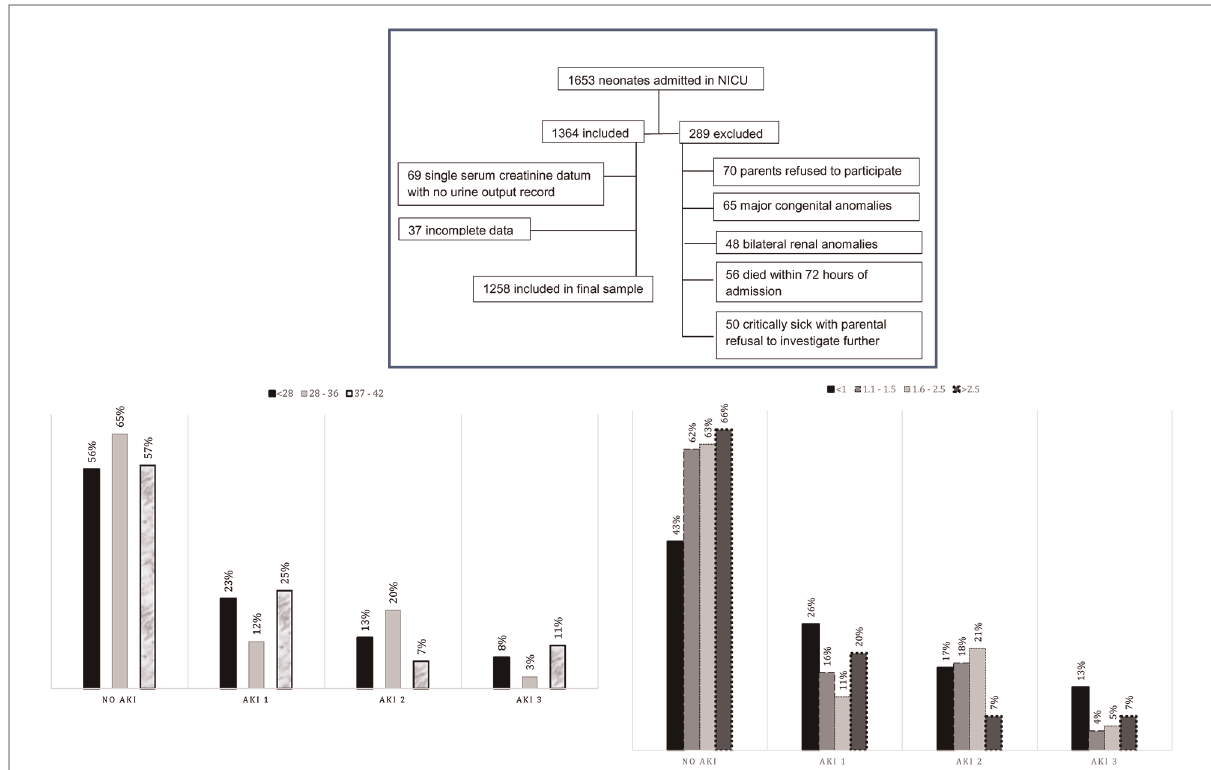
FIGURE 1 Consort fl ow chart of selected patients. Graph 1: Gestational age-based strati fi cation of AKI. Graph 2: Neonatal weight-based strati fi cation of AKI. AKI, acute kidney